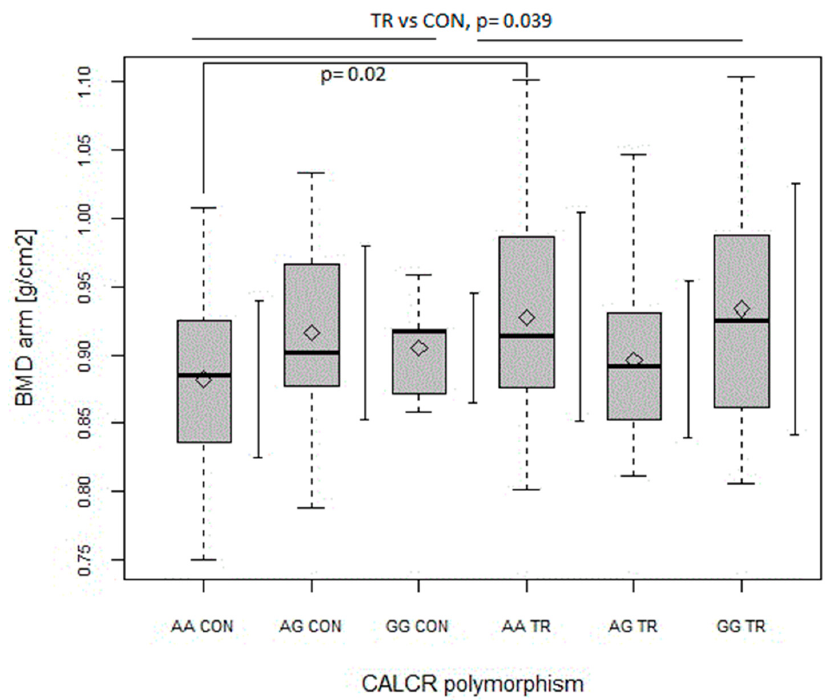
Figure 6. The effect of CALCR polymorphism on bone mineral density (BMD) (g/cm 2 ) of the arm in control (CON) and trained (TR) group. Main effects: CALCR NS TR vs. CON ( p = 0.039; F = 4.31). CALCR x TR vs. CON ( p = 0.022; F = 3.88). Key: ♦ —mean; boxplots—median Q1–Q4 and mean ± SD.